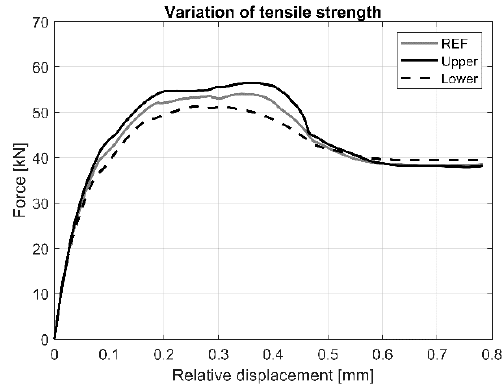
Figure 13. Load vs. load-relative displacement curves for the variation of tensile strength of AAC.